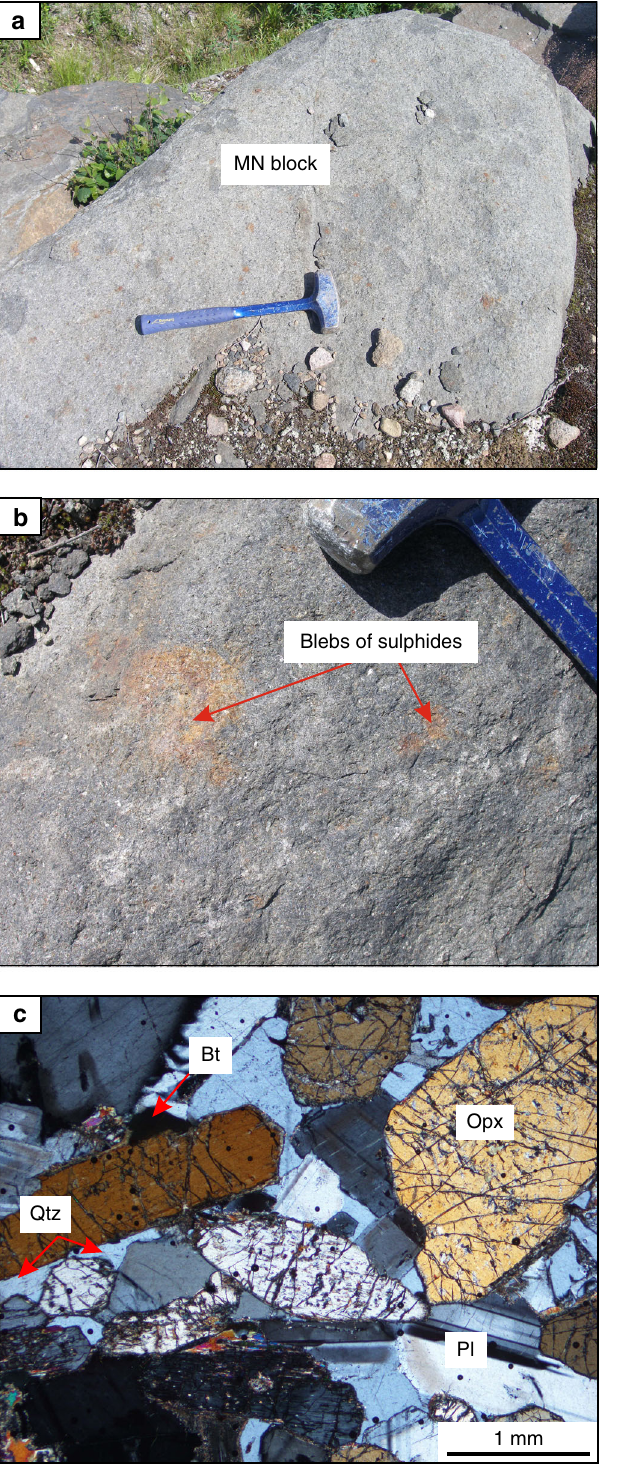
Fig. 4 Melanorite body hosted by quartz gabbro of the Elm traverse in the South Range of the SIC. a Field photograph of an outcrop of sulphides- bearing melanorite body hosted by quartz gabbro. The length of the hammer head used for scale is 11 cm. b Blebs of sulphides on a fresh surface of melanorite. The length of a marker used for scale is 1 cm. c Photomicrograph showing extensive alteration of euhedral/subhedral orthopyroxene and subhedral plagioclase with minor interstitial biotite and quartz. Sample 480 in cross-polarized